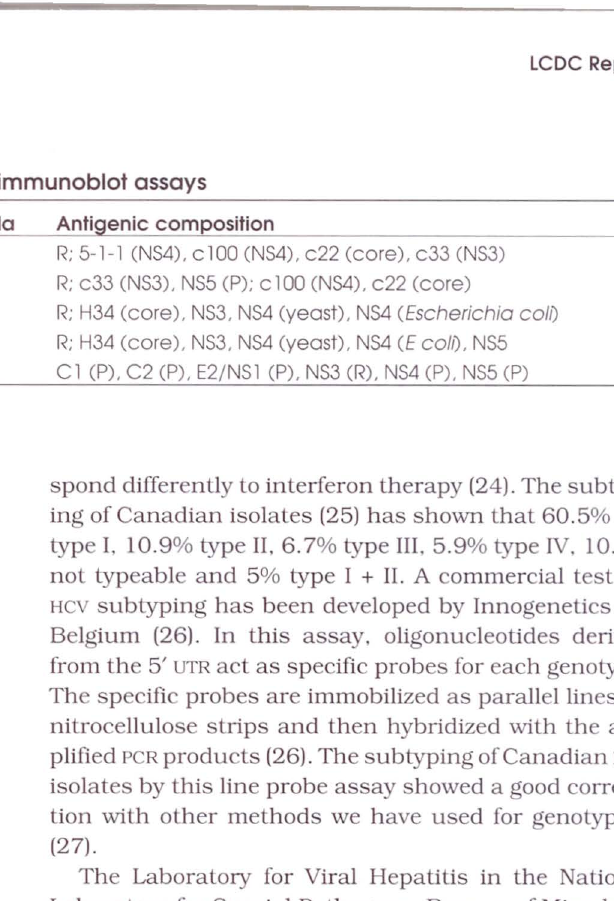
Antigenic composition of second- and third-generation immunoblot